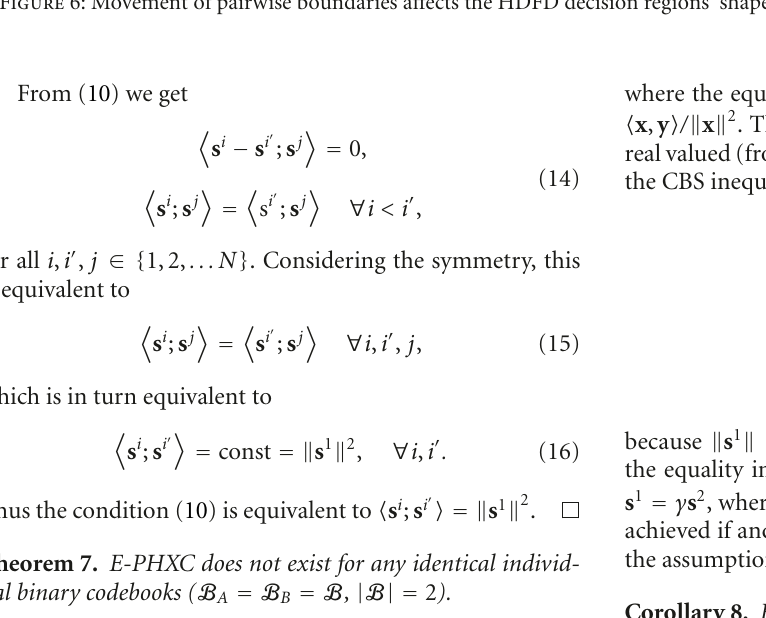
Figure 6: Movement of pairwise boundaries a ff ects the HDFD decision regions’ shape (real-valued 2-dimensional example codebook).